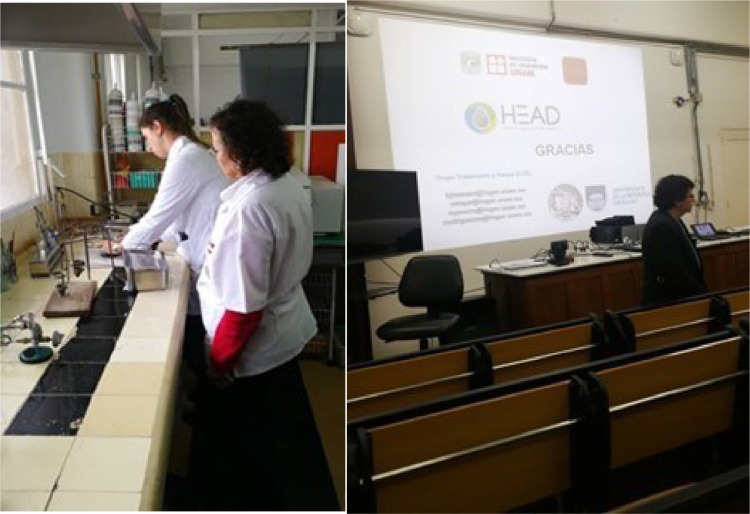
UDLR Laboratory.